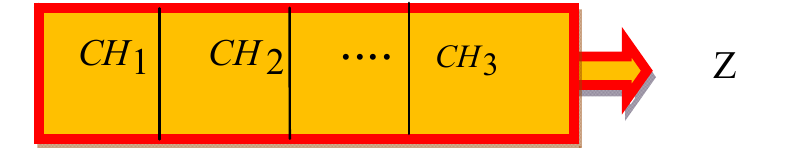
Figure 2. Solution encoding for optimal centroid selection.